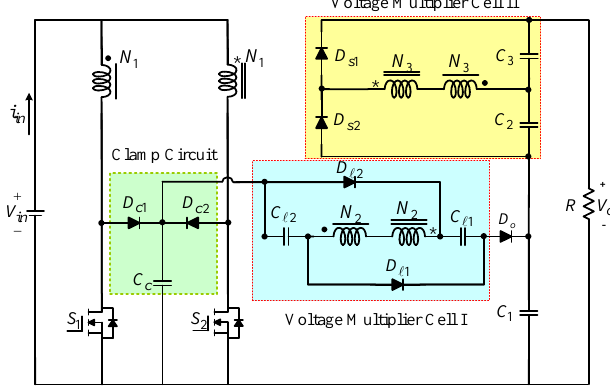
Figure 1. Circuit configuration of the proposed converter. represent the leakage inductances. Assuming that